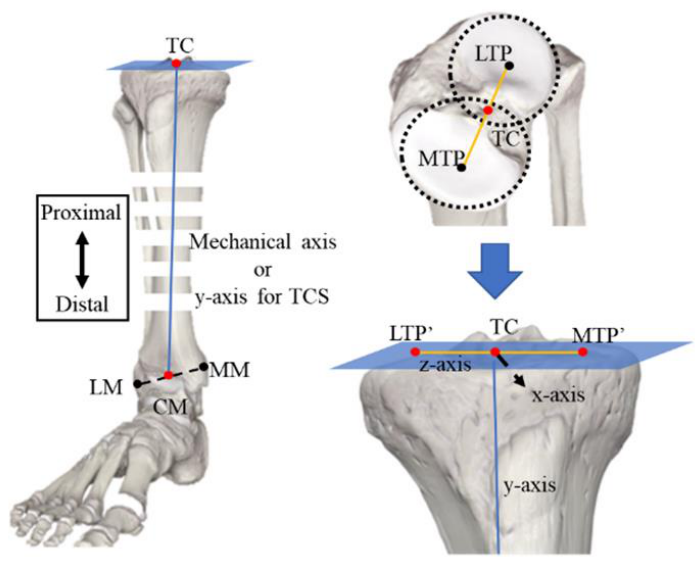
Figure 3. Generalized method to define TCS using anatomical points [41].